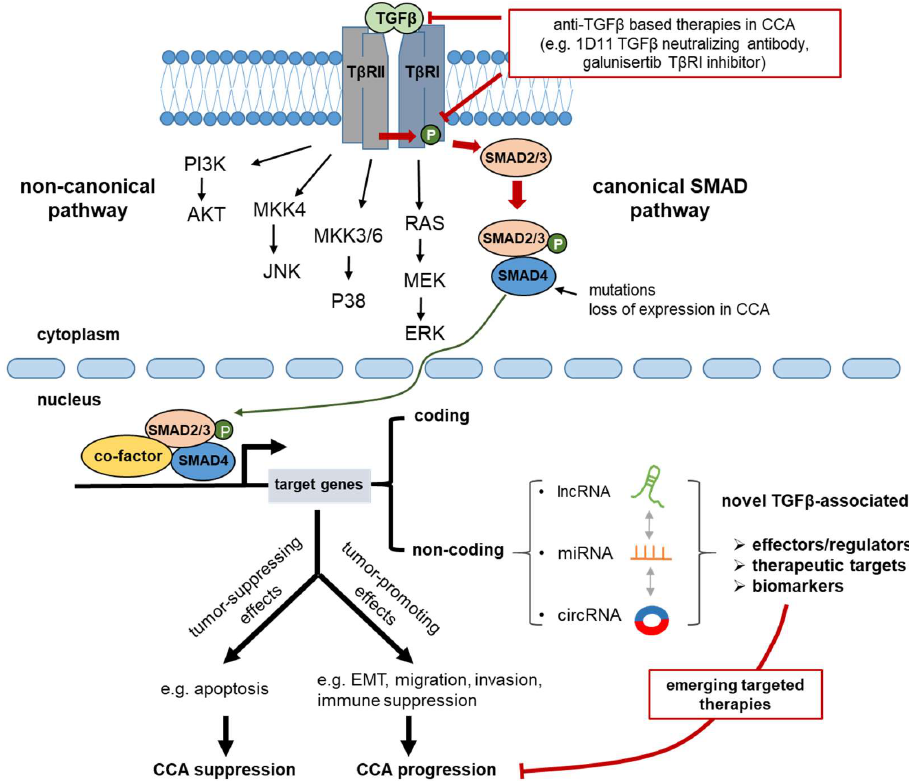
Figure 2. TGFβ signaling in cholangiocarcinoma (CCA) progression. TGFβ